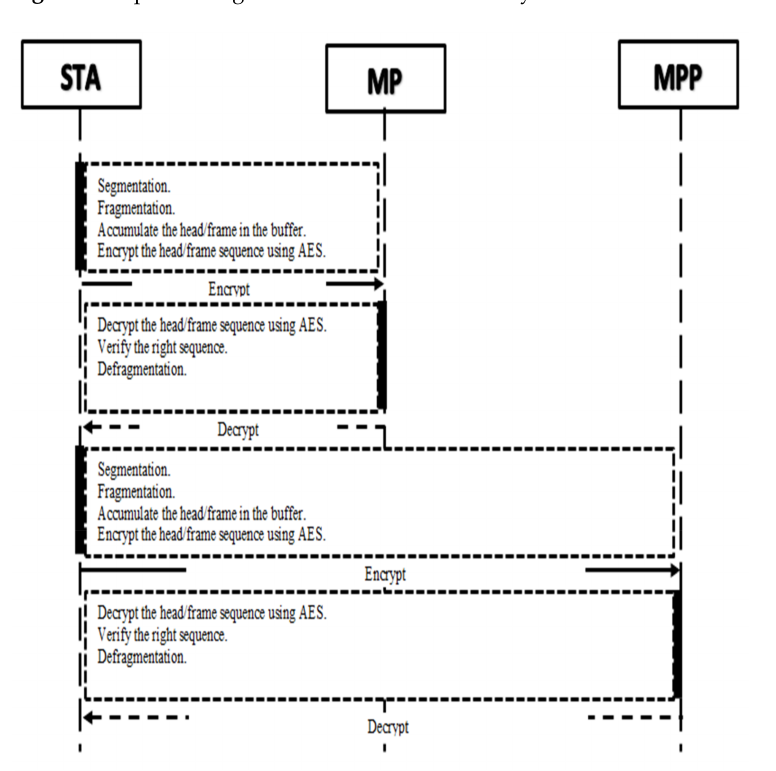
Figure 8. Authentication